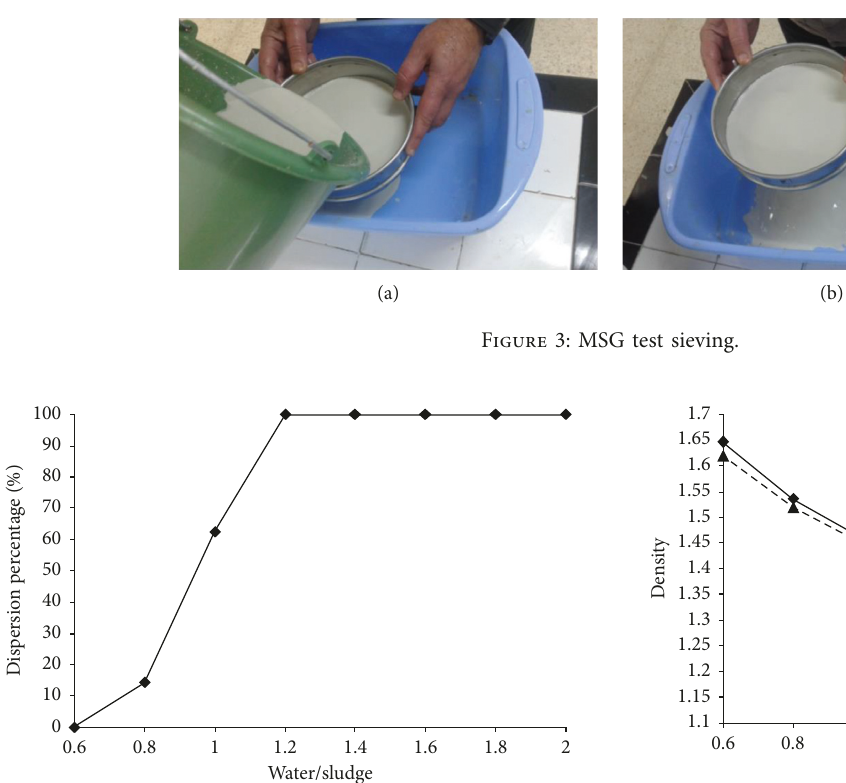
Figure 4: Dispersion percentage as a function of the water/sludge ratio of the different MSGs. Table 8: The physical properties of the different MSGs. Grout Water/sludge reference